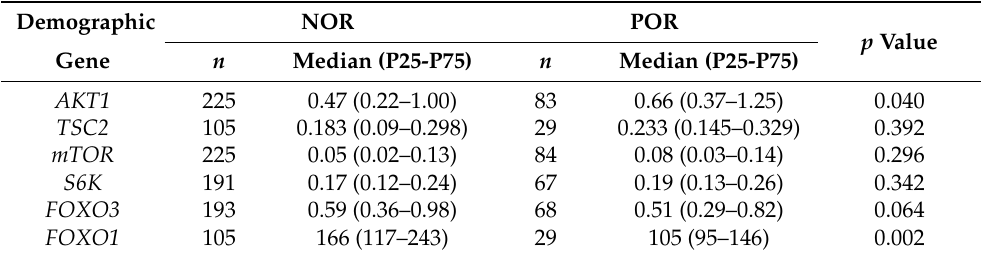
Table 5. AKT1 , FOXO3 , FOXO1 , mTOR , S6K , and TSC2 expressions according to ovarian response group. For statistical details, see Materials and